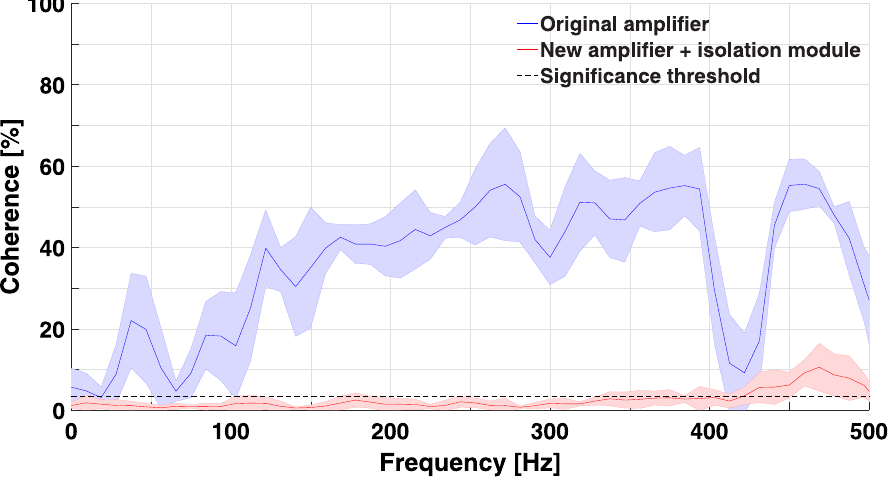
Fig 4. Mean ± SEM of the raw intermuscular coherence of the left and right biceps with left biceps activation only ( N =